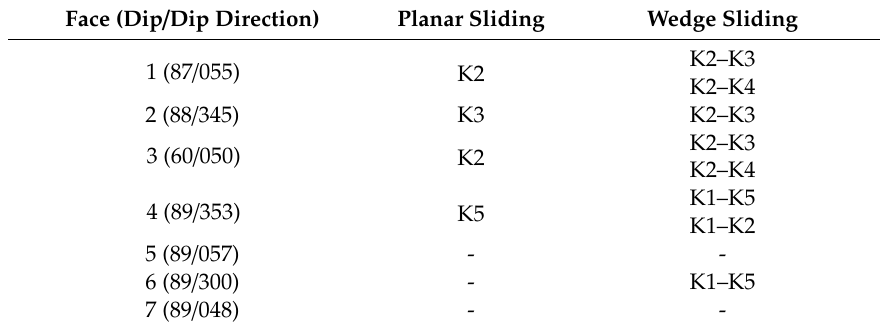
Table 3. Summary of potential failure mechanisms that may a ff ect excavation faces from 1 to 7.